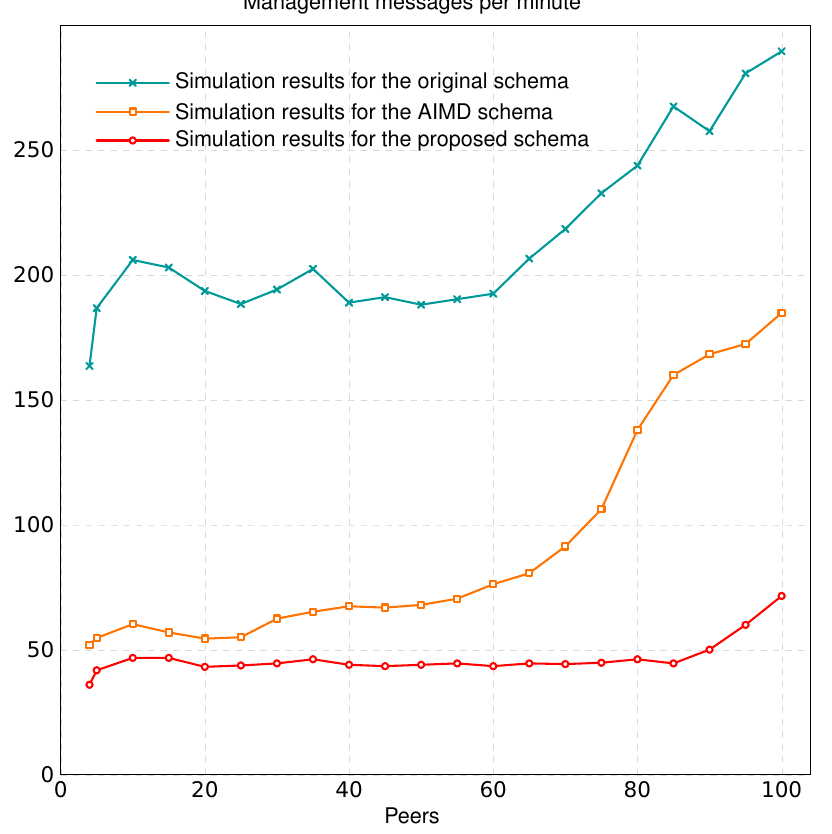
Figure 3. Comparison of management overhead for different population sizes (from 4